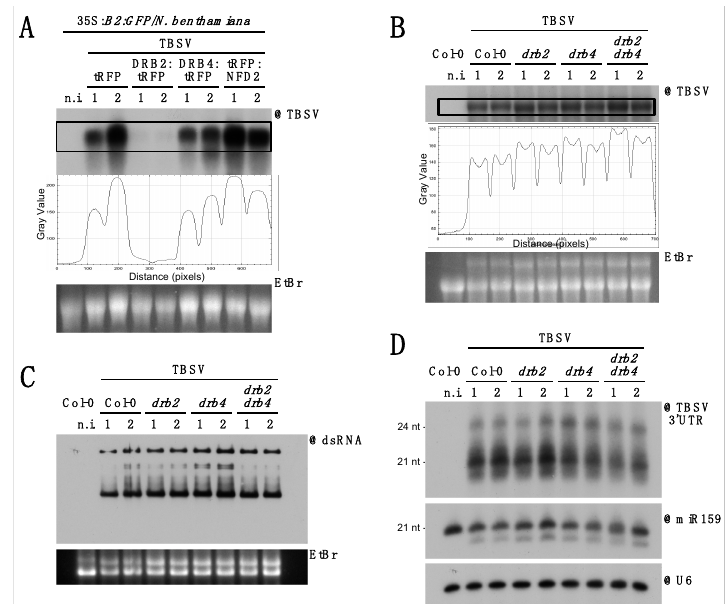
Figure 5. Involvement of DRB2, DRB4 and NFD2 in TBSV infection. ( A ) Northern blot analysis of RNA from 35S: B2:GFP / N. benthamiana leaf disks agroinoculated with the constructs indicated and subsequently infected with TBSV. Each sample is a pool of 50–60 leaf disks taken from several infected leaves on 2–3 plants. ( B ) Northern blot analysis of high molecular weight RNA to detect TBSV at 9 dpi in systemically infected rosette leaves of A. thaliana mutant lines. Quantification of signal intensity is provided. Each sample is a pool of 4–5 plants. ( C ) Northwestern blot to detect dsRNA in the samples described in ( B ). In ( A – C ) EtBr gel staining was used as a loading control. ( D ) Northern blot analysis of low molecular weight RNA to detect TBSV-derived siRNA. As loading control, the same membrane was separately hybridized to miR159- and snU6-specific probes. In all the blots a non-infected control (n.i.) was included on the far left. Except for the non-infected control, two samples were analyzed per genotype / transgene (1 and 2 in the labels).